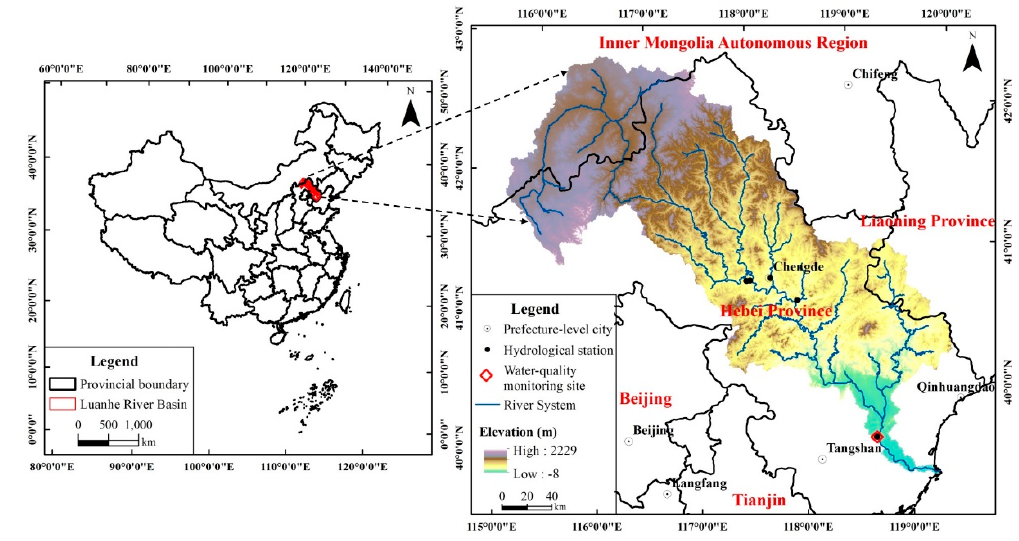
Figure 2. The Luanhe River Basin.